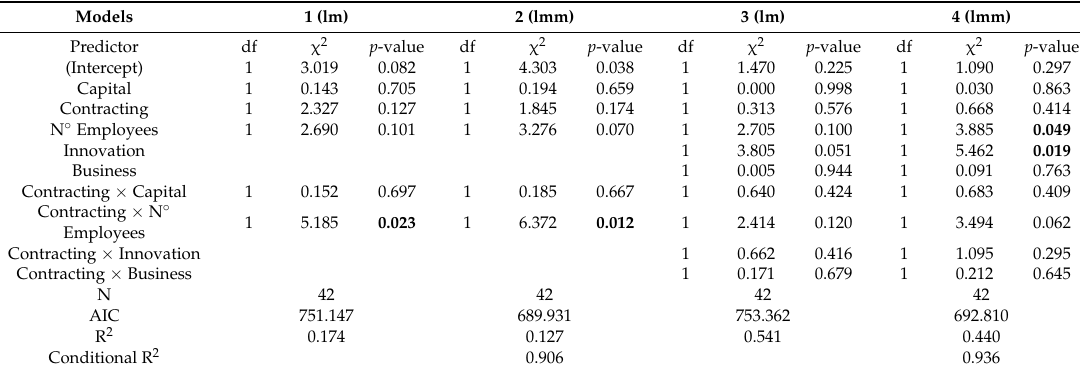
Table 3. Results of the linear and mixed linear effect models for growth in production (t/month) in the last five